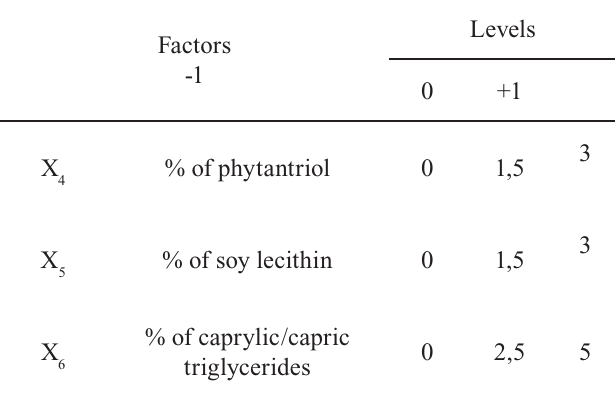
TABLE II - Factors studied in Box-Behnken design and their +1, 0, -1 levels at phase